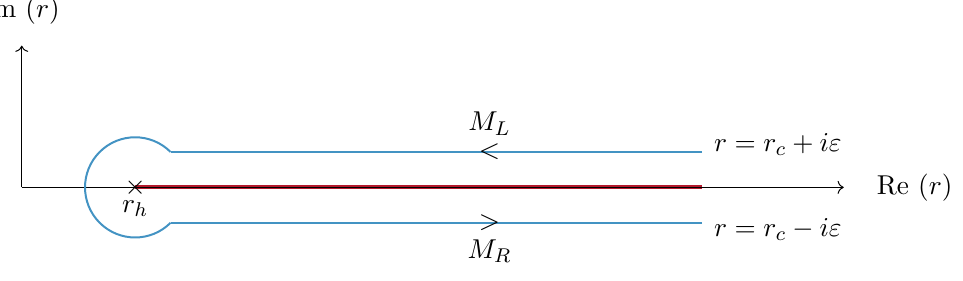
Figure 2 . Picture of bulk at a fixed v : red line is a branch cut from horizon to